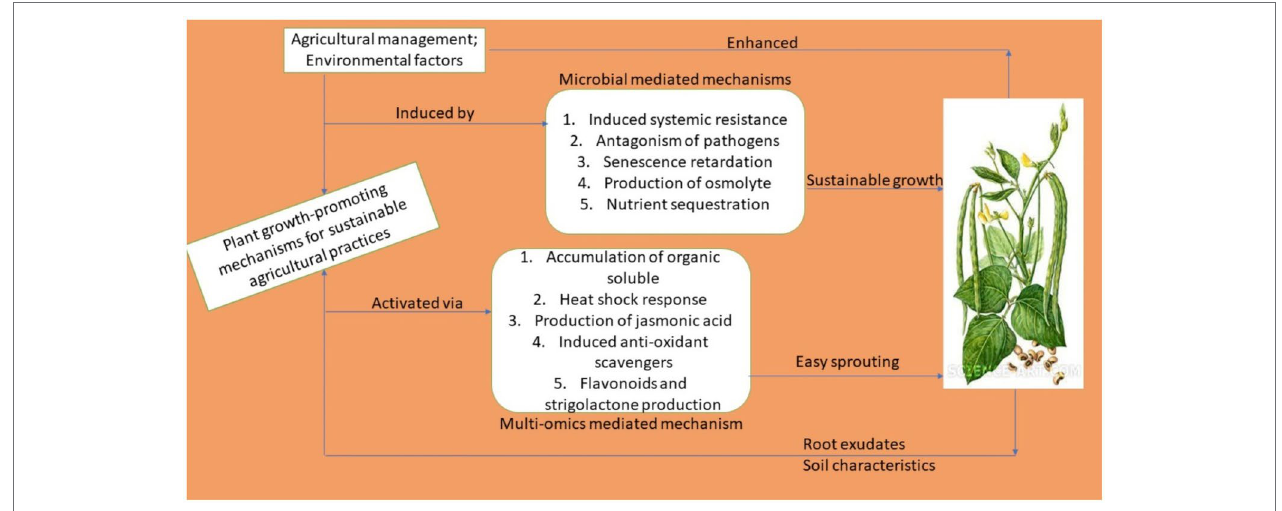
FIGURE 3 | Mechanisms of action of smart biotechnological techniques deployed in cowpea productivity